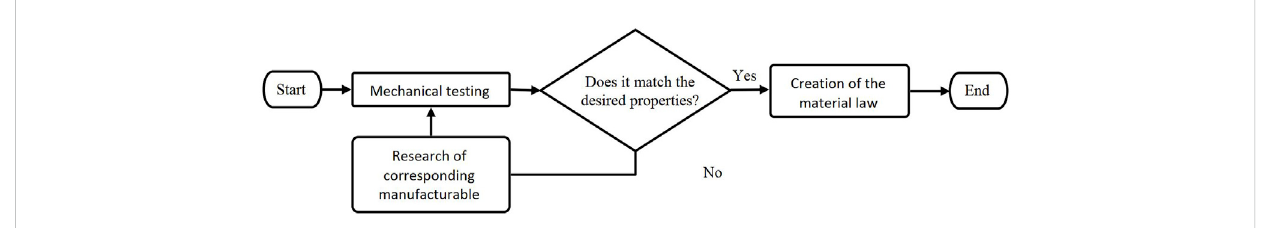
FIGURE 3 Reverse engineering procedure: from numerical properties to manufacturable